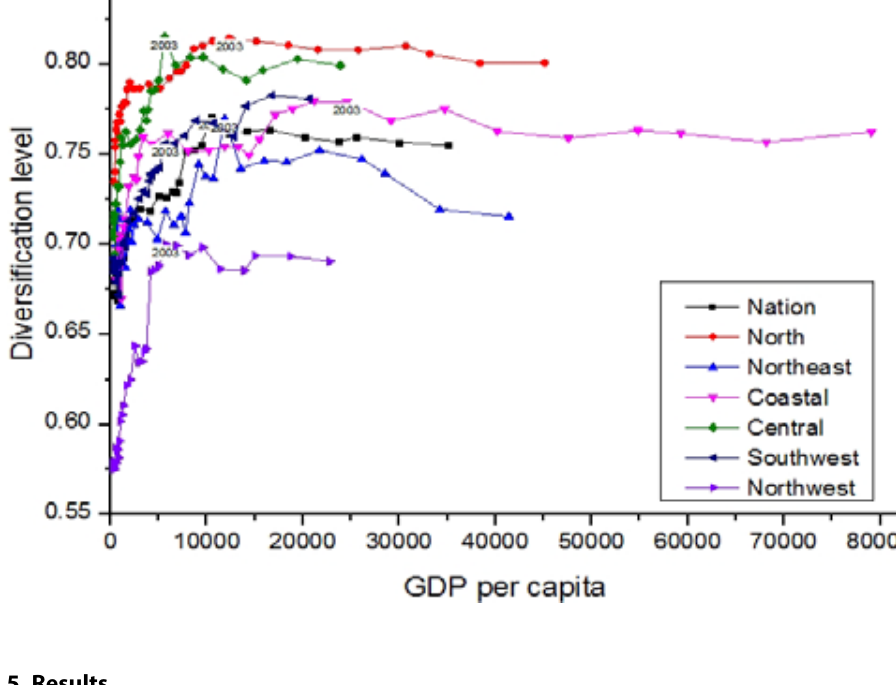
Figure 3. Diversification level and GDP per capita for national average and six regions,